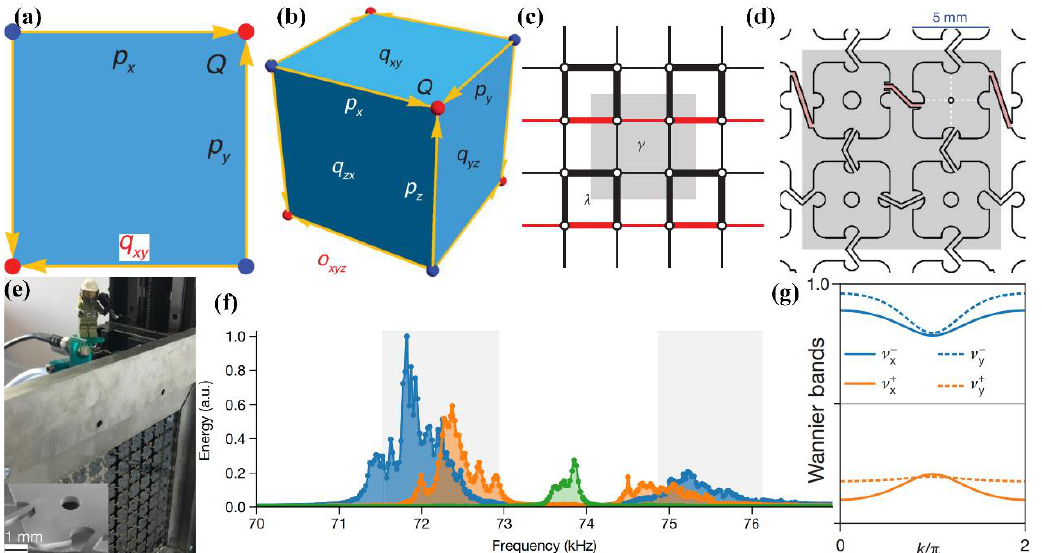
Figure 4. Quantized multipole insulators. ( a ) Bulk quadrupole moment q xy , edge dipole moments p i , and corner charges Q [11]. ( b ) Bulk octupole moment O xyz , surface quadrupole moments q ij , hinge dipole moments p i , and corner charges Q [11]. ( c ) A 2D tight-binding model of quadrupole insulators. Red (black) lines represent negative (positive) hopping terms. Thin (thick) lines indicate intracell (intercell) hopping terms [105]. ( d ) Metamaterial structure. Dashed white lines represent the two nodal lines of the out-of-plane modes which are coupled based on the bent beams [105]. ( e ) Photo of the experimental sample [105]. ( f ) The spectrum for the quadrupole insulator [105]. ( g ) The schematic of the Wannier bands [105].